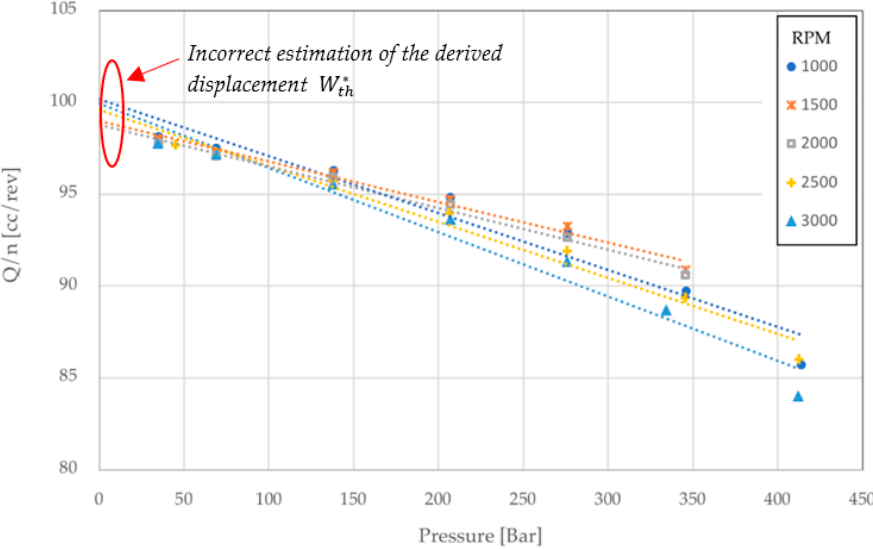
Figure 1. Incorrect interpretation of the method presented in this document.